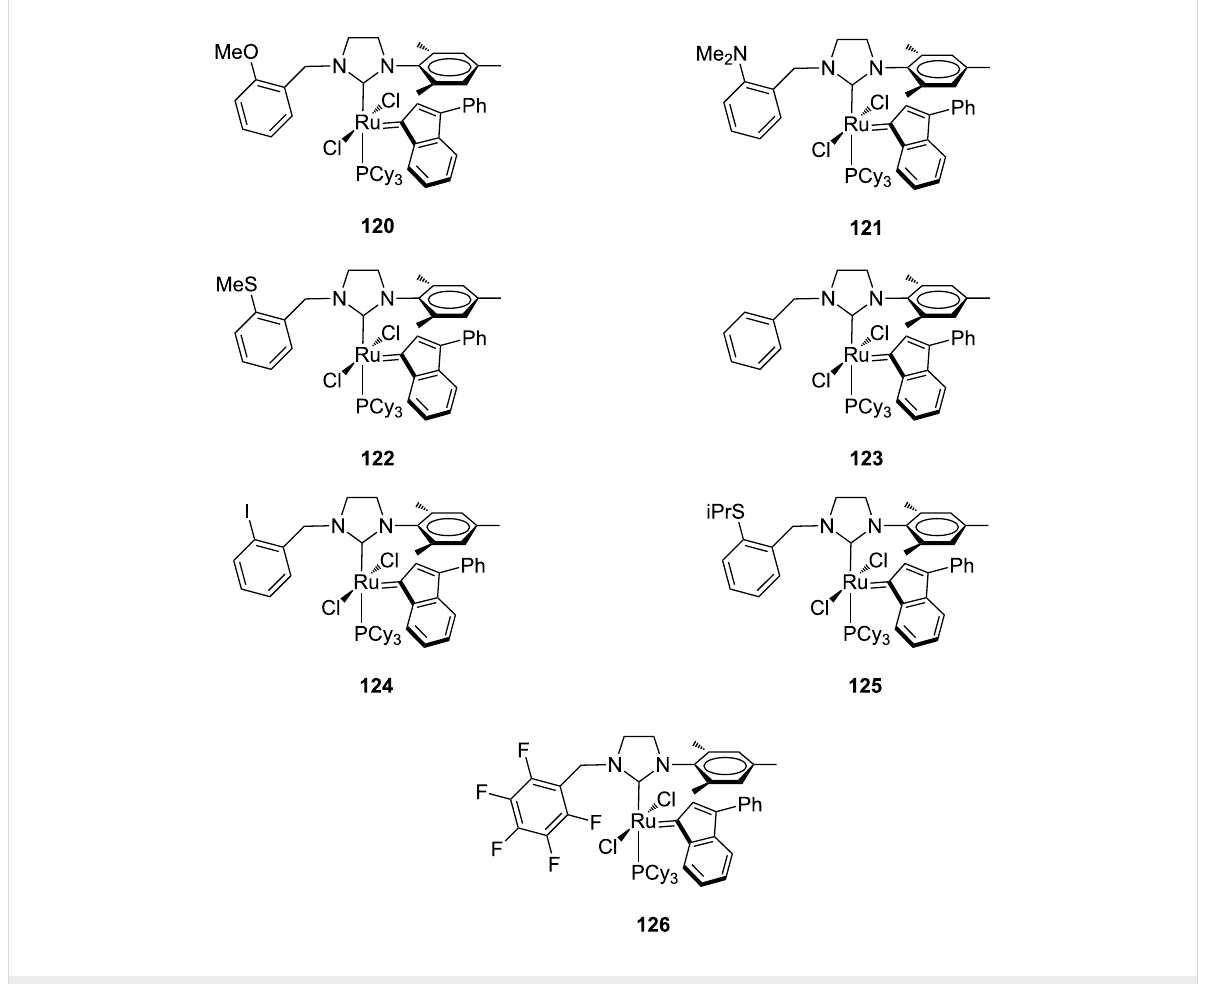
Figure 23: Indenylidene-type complexes 120 – 126 with N -benzyl, N’ -mesityl